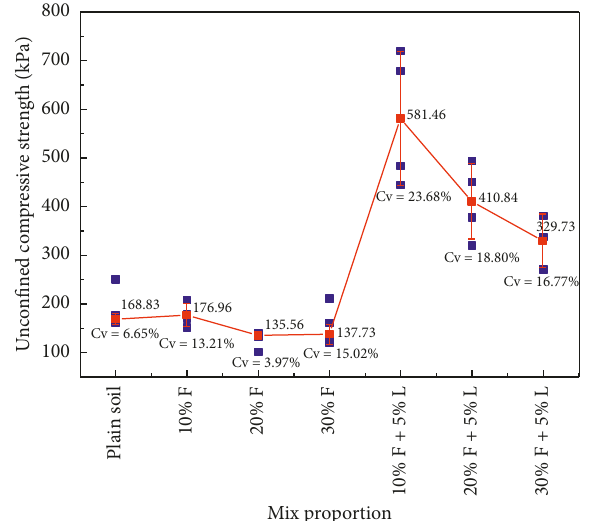
Figure 8: Unconfined compressive strength curve of stabilized soil (7